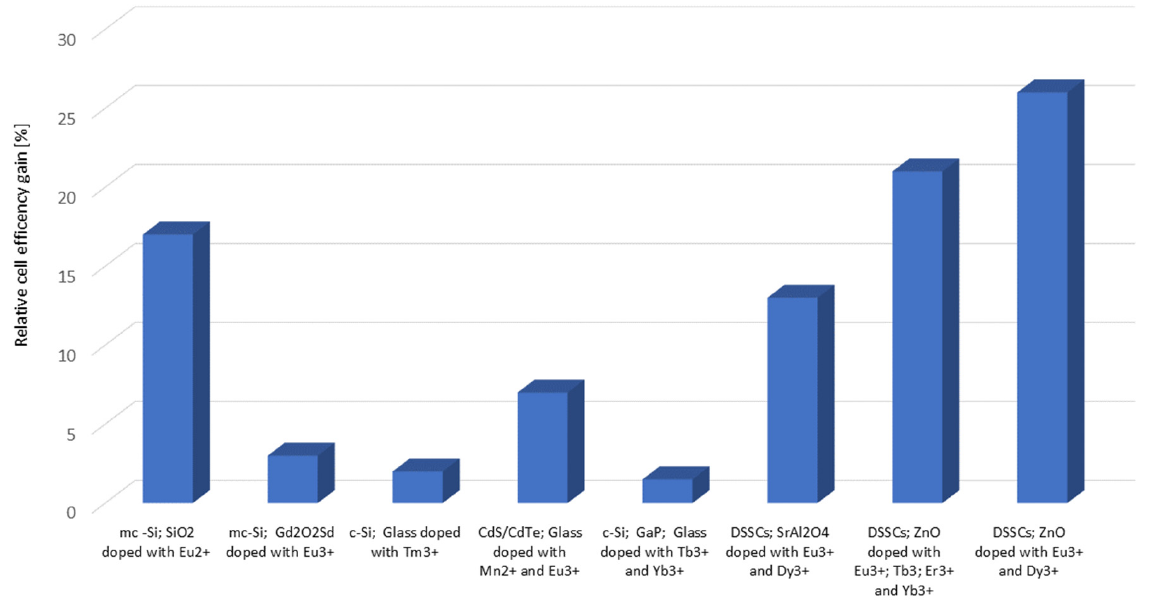
Figure 4. Relative efficiency of various solar cell categories, equipped with specific converting layers, based on different rare earth elements, based on [22,67–71].